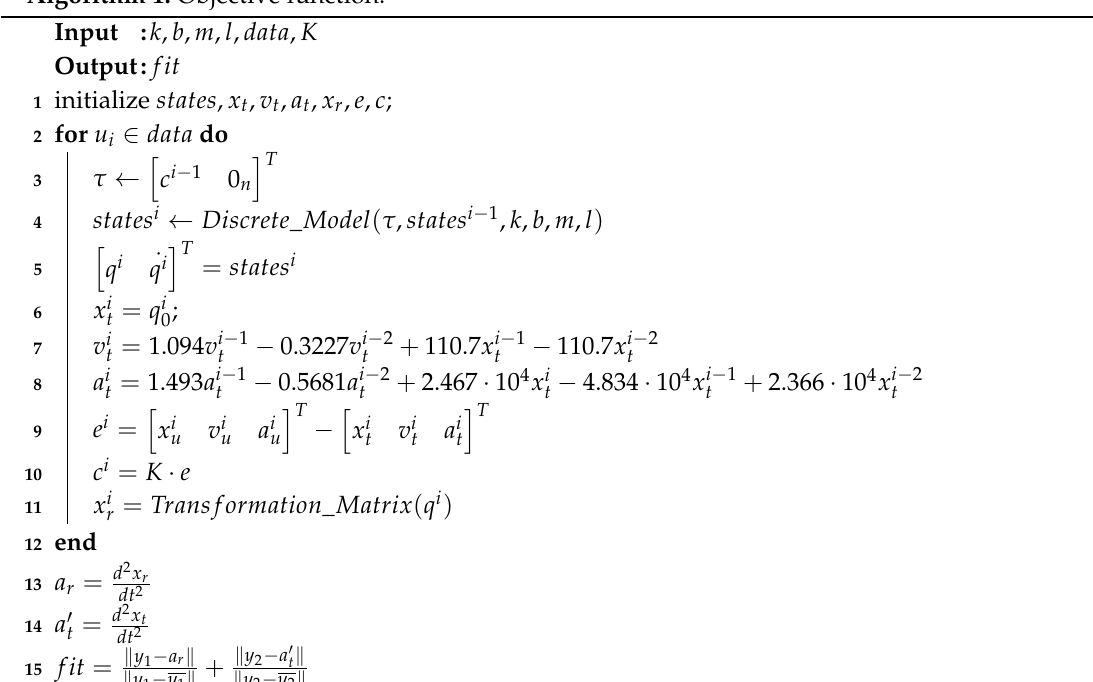
Algorithm 1: Objective function.